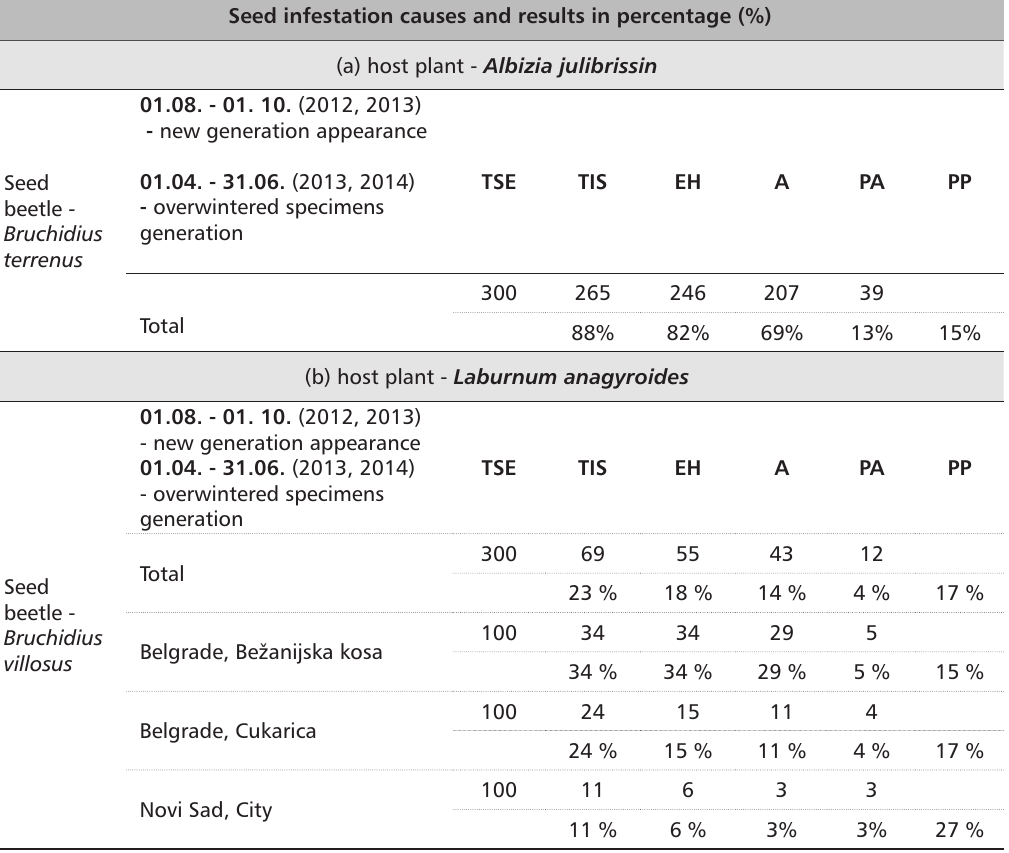
TABLE 2. Host plant seed infestation cause’s and results in percentage (%) with total number of reared insects for two months laboratory observation